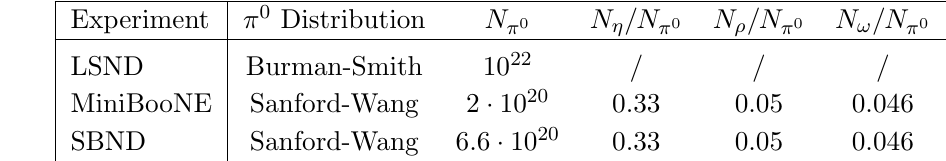
Table 3. Summary of the relevant characteristics of mesons productions in the experiments con- sidered. Note that the lower energy at LSND prevents the production heavier